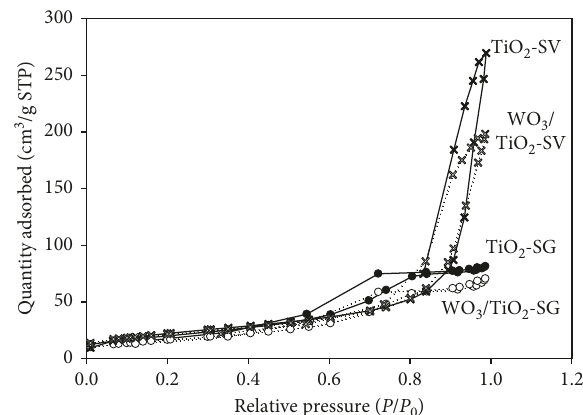
Figure 2: Nitrogen adsorption-desorption isotherms for supports and catalysts.